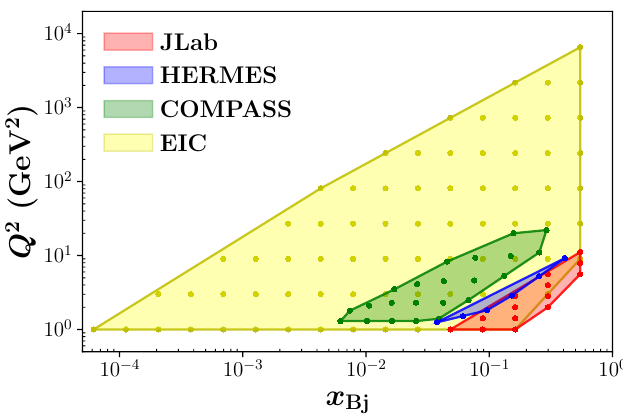
Figure 2 . Kinematical reach of Q 2 (GeV 2 ) versus x Bj for data from existing experiments at Jeffer- son Lab (red), HERMES (blue), COMPASS (green), and the future EIC (yellow). Bin centers are in- dicated by filled circles, with each bin representing measurements for different values of z